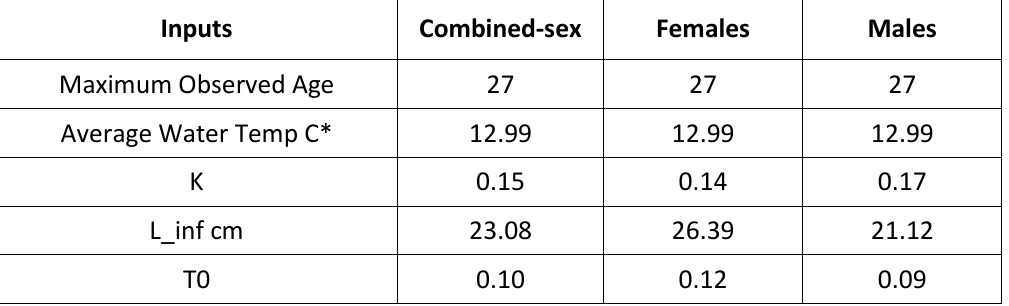
Inputs for estimating natural morality for horseshoe crabs. NOAA average water temperatures for Lewes DE